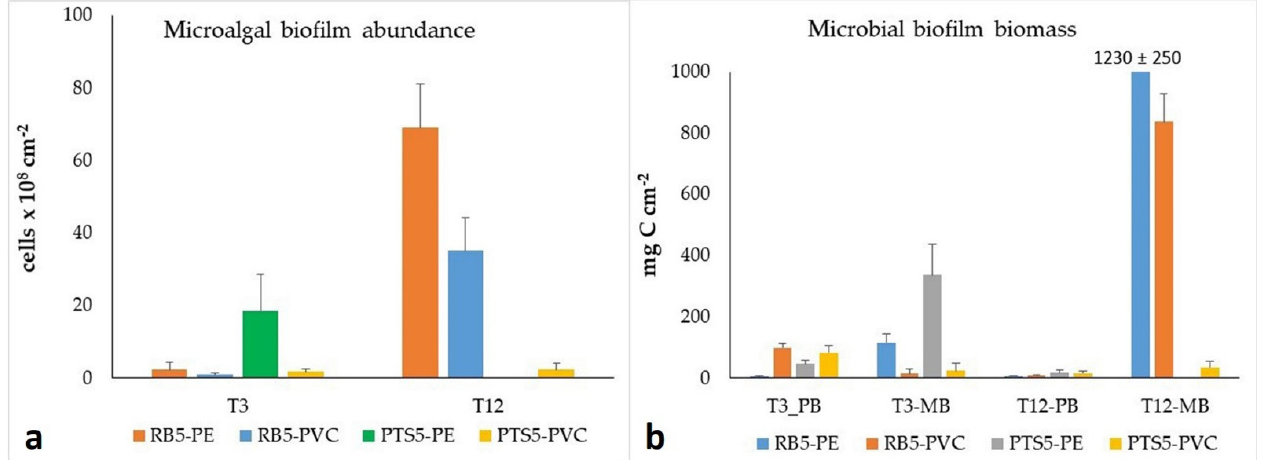
Figure 7. Mean values + standard deviations of ( a ) the microalgal biofilm abundance and ( b ) biofilm biomass (B) of prokaryotes (P) and microalgae (M) observed on plastic materials submerged in the Road Bay area at 5 m for 3 and 12 months (T3 and T12, respectively). Road Bay (impact station); PTS, Punta Stocchino (control station). PVC: Polyvinyl chloride; PE: Polyethylene.